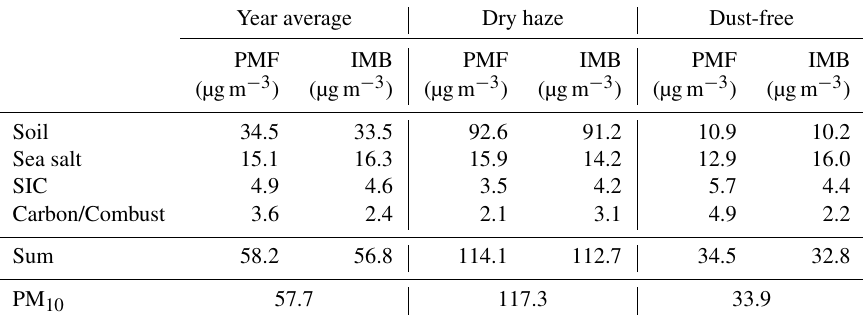
Table 3. Comparison between IMB and PMF results, grouped into four main classes. PM 10 represents gravimetric measurements of total mass (in IMB: Soil is the total of WetSoilDust ins plus WetSoilDust sol, SIC is the total of WetSIC am plus WetSIC ss + du; in PMF: SIC is the total of SIC1 + SIC2, Soil is the total of Mineral1 plus Mineral2 plus Dust +